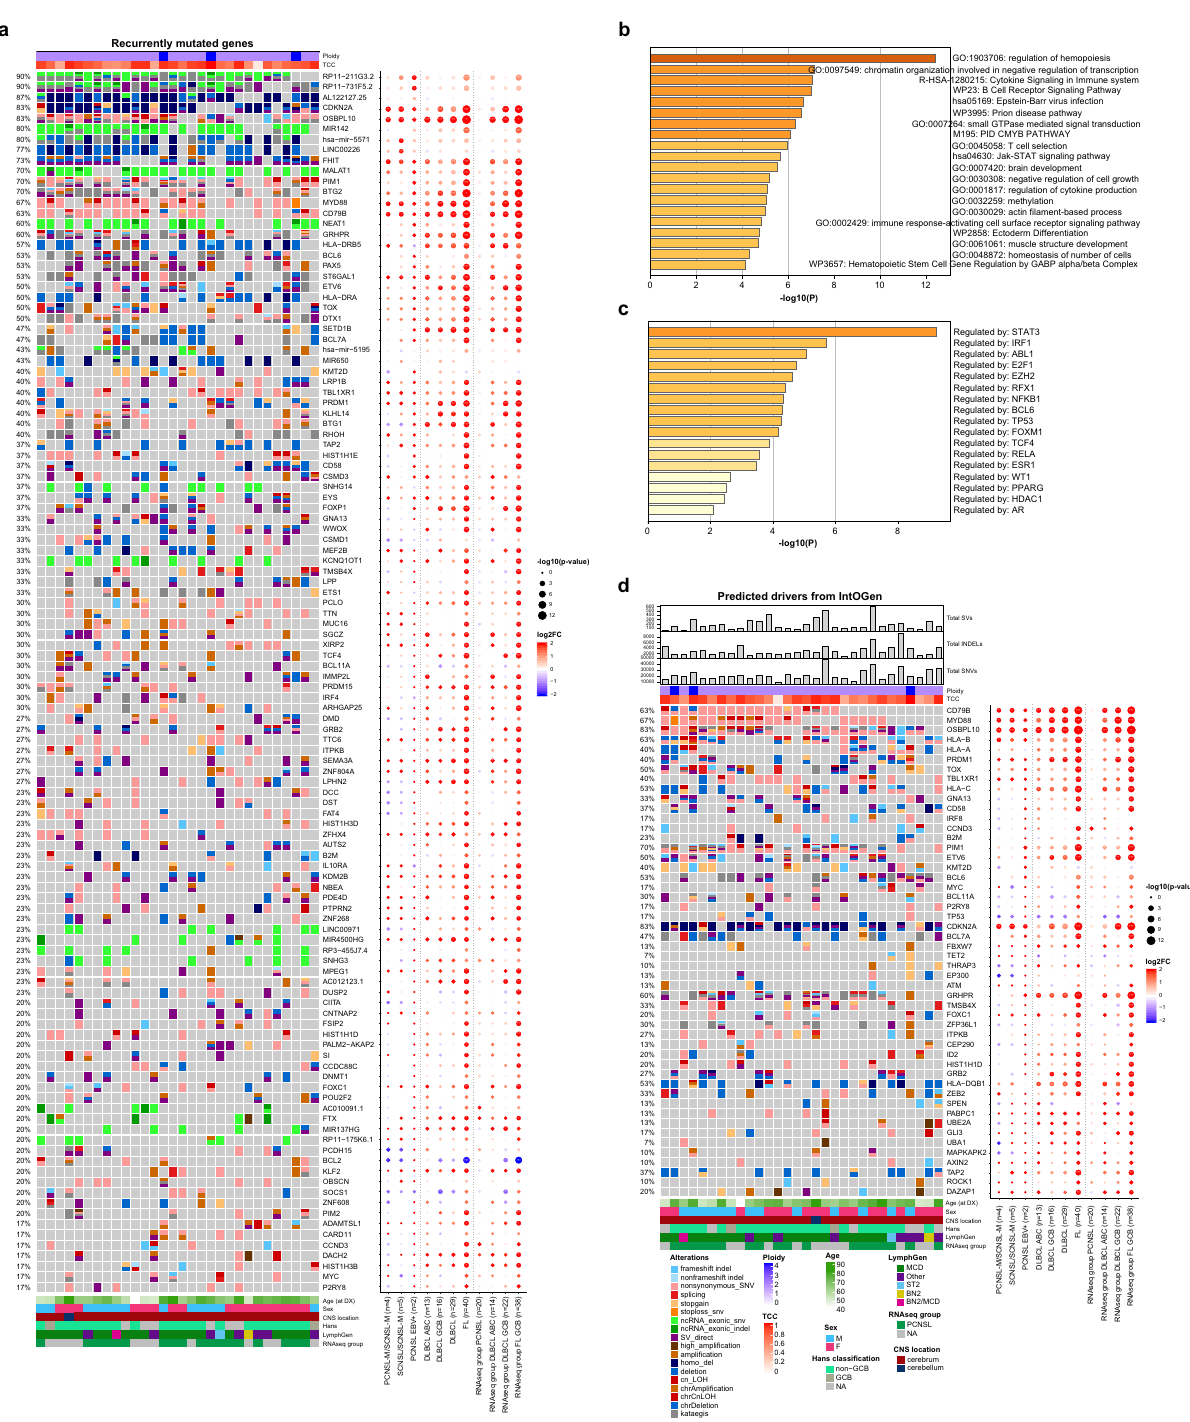
Fig. 2 Recurrent coding mutations and genomic drivers in PCNSL. Oncoprints of recurrently mutated genes, excluding IG and chromosome Y genes ( a ). Mutated genes are listed from top to bottom depending on their alteration frequency. The corresponding dot plot re fl ects the log2 fold change and signi fi cance of alteration frequencies in the other subcohorts and RNAseq subgroups compared to PCNSL. The recurrently mutated genes (listed in the oncoprint in a) were analyzed by Metascape 68 to identify pathway and process enrichment ( b ) and transcriptional regulatory networks (TRRUST) ( c ). Metascape adopts the hypergeometric test and employs the Benjamini-Hochberg correction for multiple testing. Oncoprints of driver genes in PCNSL ( d ). The top panel of the oncoprint shows the total numbers of structural variants (SVs), small insertions/ deletions (INDELs), single nucleotide variants (SNVs), estimated ploidy, and genomic tumor cell content (TCC). Mutated genes are ranked by IntOGen. The corresponding dot plot re fl ects the log2 fold change and signi fi cance of alteration frequencies in the other subcohorts and RNAseq subgroups compared to PCNSL. In panels ( a ) and ( d ) the size of the dots demonstrate the signi fi cance according to a two-tailed Fisher ’ s exact test not corrected for multiple